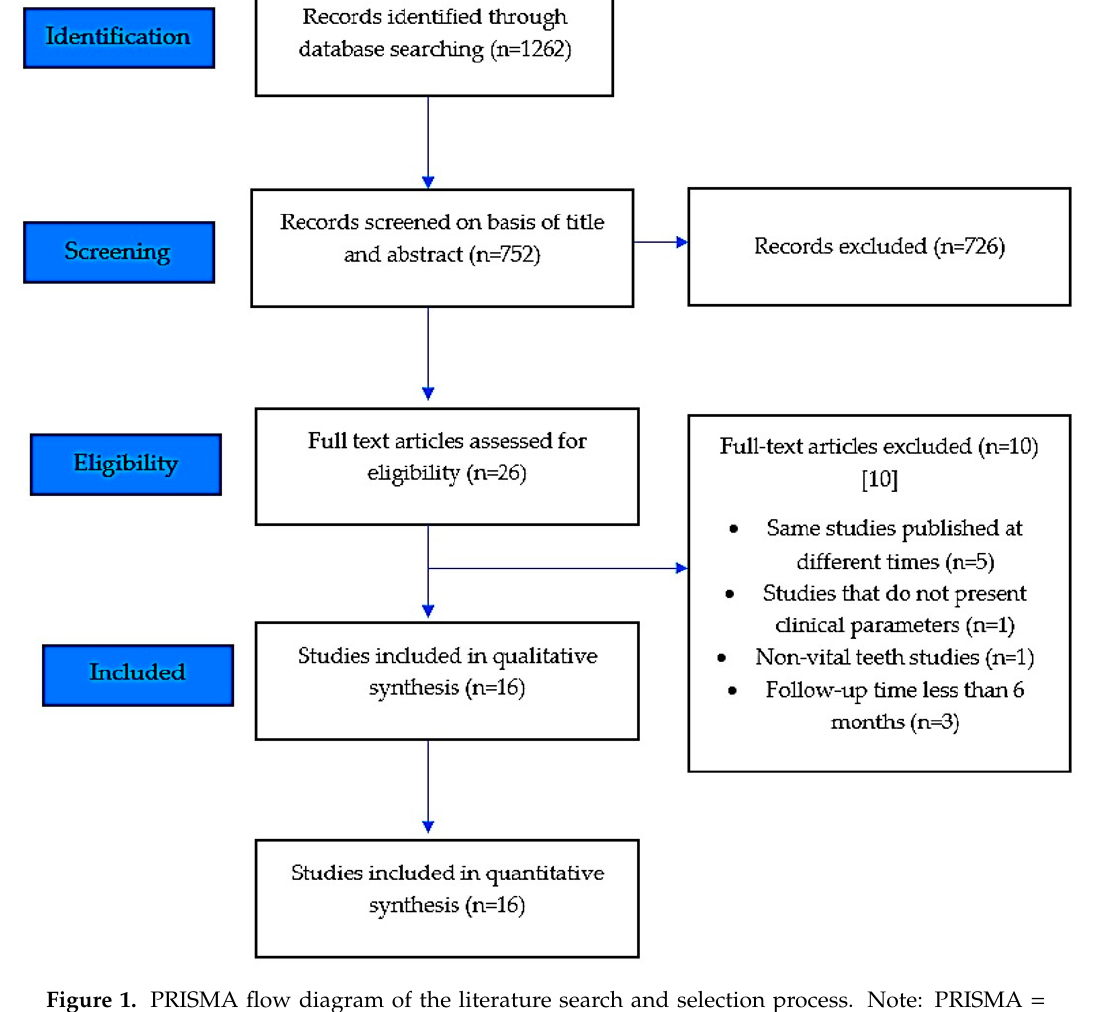
Figure 1. PRISMA flow diagram of the literature search and selection process. Note: PRISMA = Preferred Reporting Items for Systematic Reviews and Meta-Analyses [12].